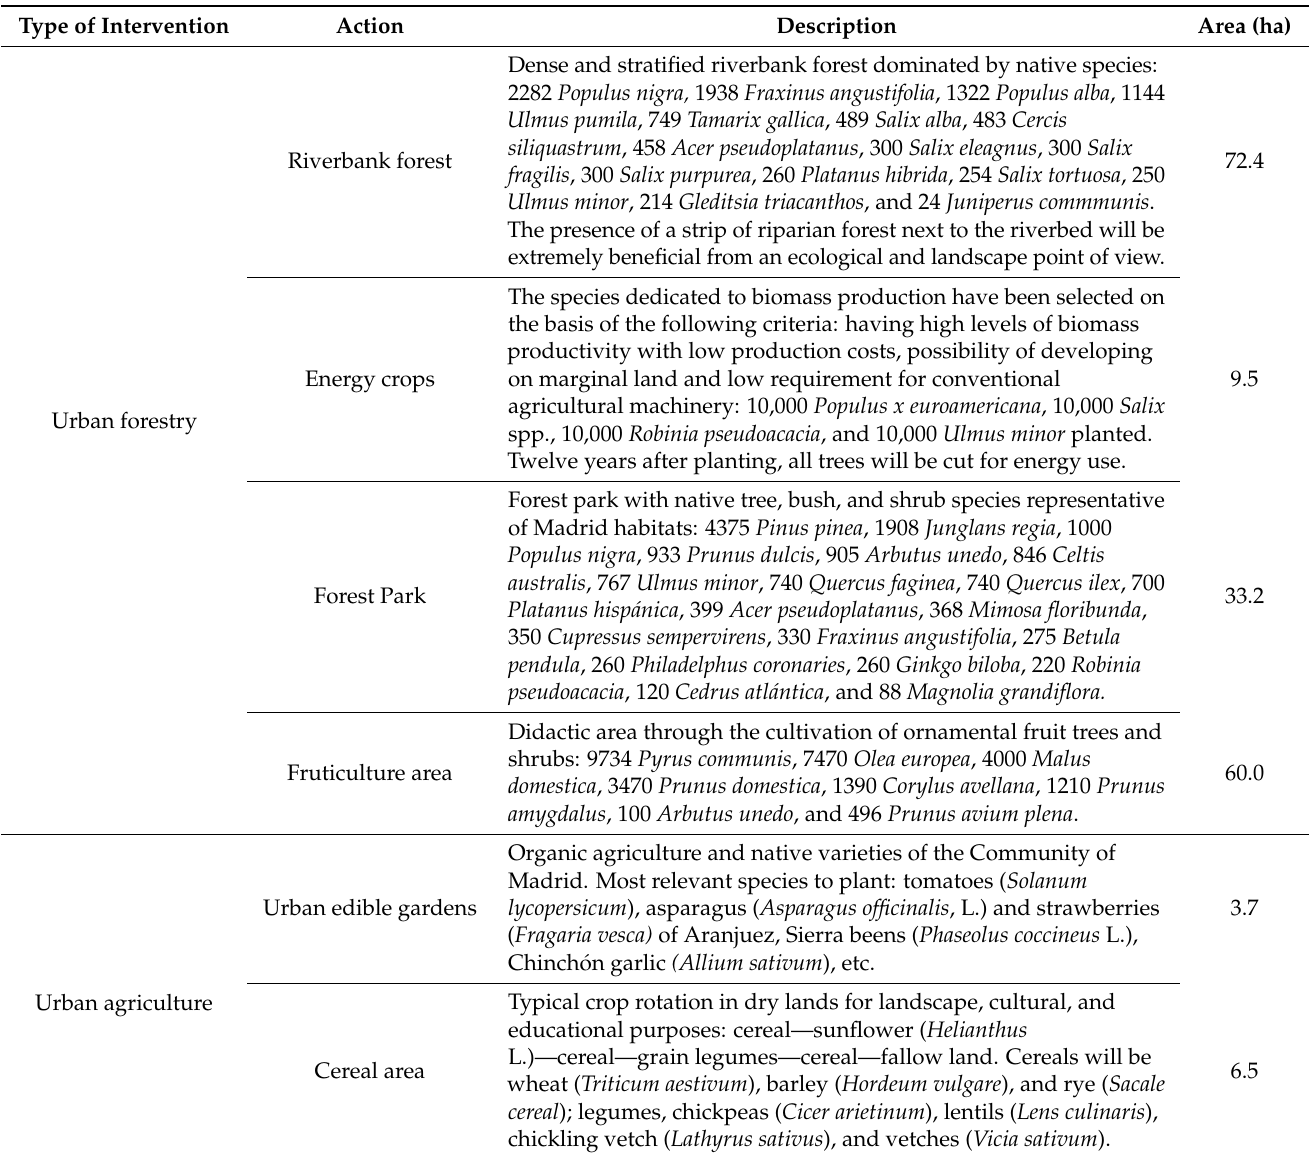
Table 1. Description of the urban green infrastructure actions under study.